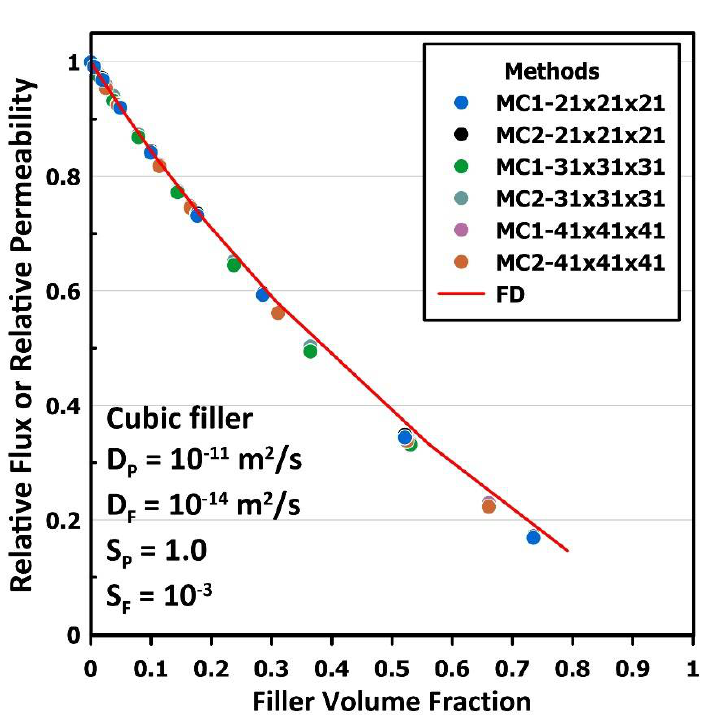
Figure 6. The plot of the relative steady-state flux or relative permeability of an MMM with a cubic filler particle of different sizes for the two MC methods: the lattice MC (MC1) and the continuous displacement MC (MC2). Three different discretization meshes were used for comparison, and the results were compared with the results of the FD method under identical conditions.